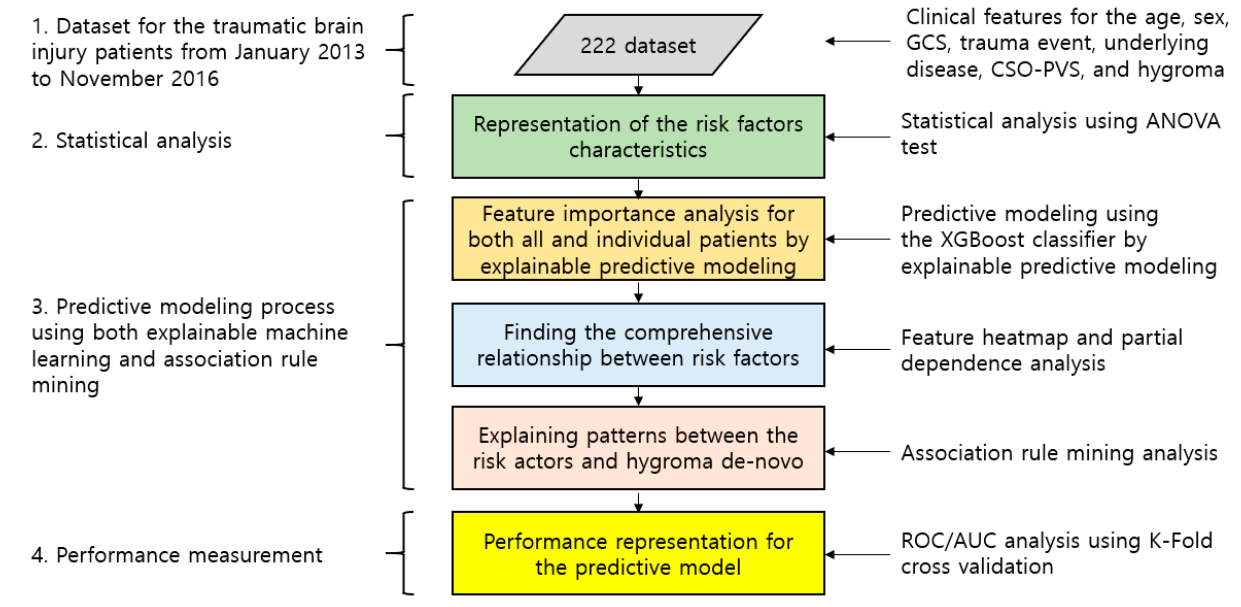
Figure 1. Research diagram for the composite analysis of the risk factors for de novo hygroma in patients with traumatic brain injury using predictive modeling and association rule-mining.